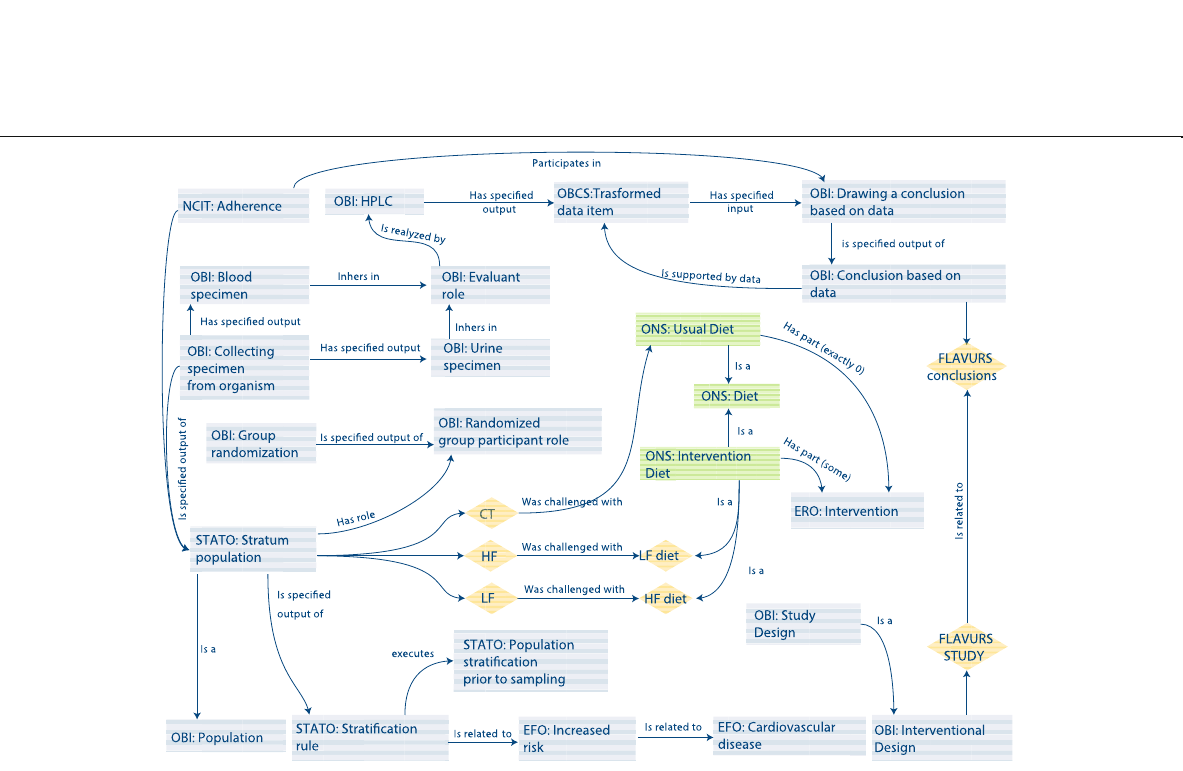
Fig. 3 Application scenario to the description of an intervention study: modeling of the FLAVURS study with the ONS. Terms in rhombus indicate instance-level terms specific to the FLAVURS study (i.e., the specific conclusion of the FLAVURS study), while terms in rectangular boxes represent general concept in the ONS. The presented semantic representation should be intended at the single instance level for the purpose of specifically describe FLAVURS